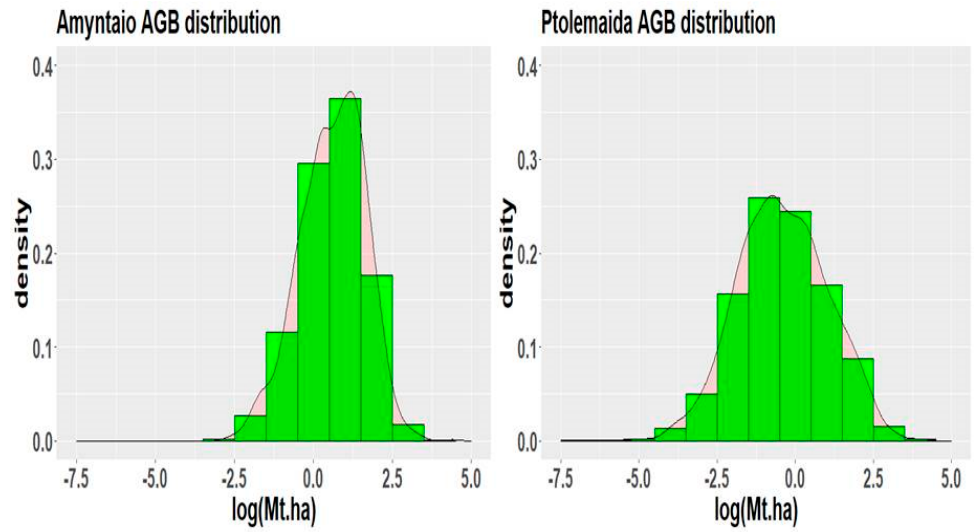
Figure 2. Histogram (frequency and density) of the logarithm of AGB (t ha − 1 ) at the study sites of Amyntaio ( left ) and Ptolemaida ( right ).